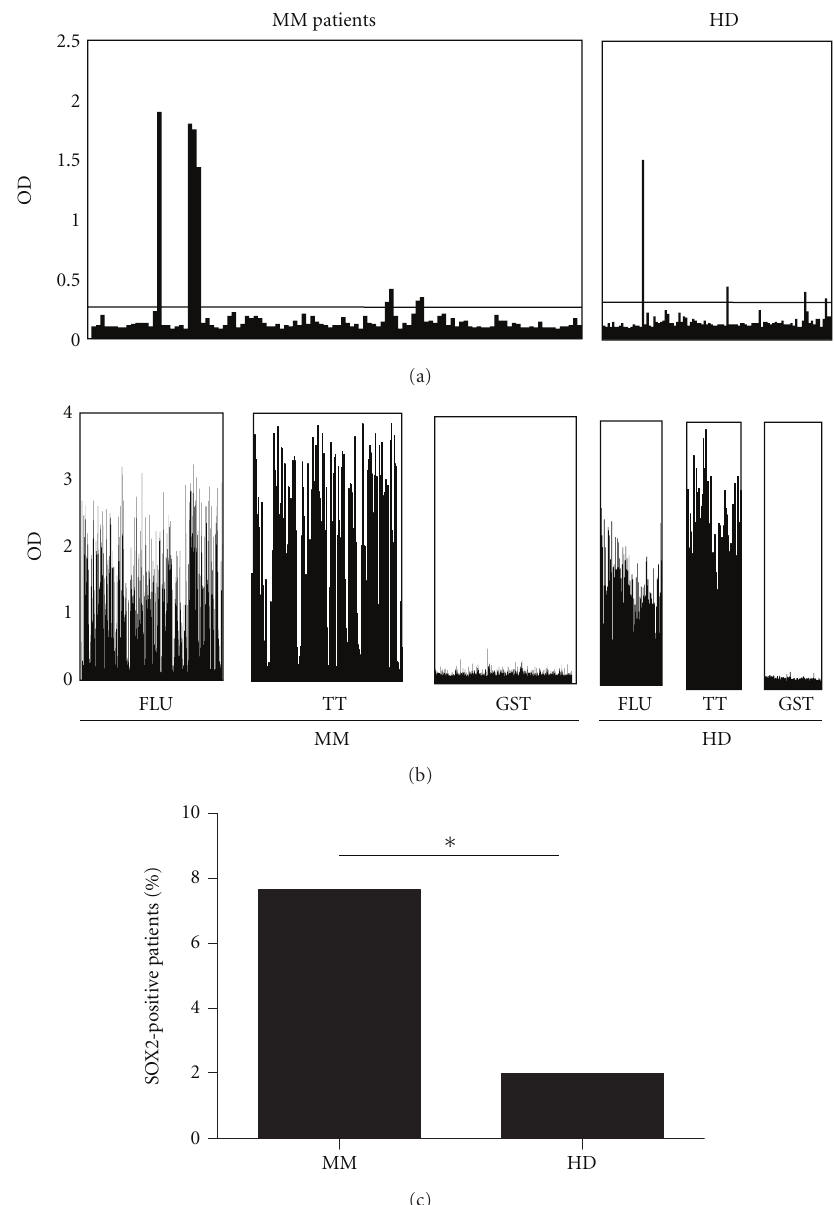
Figure 2: (a) Analysis of SOX2-specific IgG antibody responses in MM patients ( n = 1094) and in healthy donors ( n = 100). Results are shown as optical density (OD) at 405 nm. Horizontal bar represents the cut-o ff value for positivity (OD > 0.274). (b) Analysis of influenza- nucleoprotein- (FLU-), tetanus-toxoid- (TT-) and glutathione-S-transferase- (GST-) specific antibody responses in the same collective of MM patients and healthy donors. (c) Incidence of SOX2-specific antibody responses in the group of MM patients compared with the group of healthy donors (7.7% versus 2.0%). We found significantly more individuals with SOX2-specific antibody responses in the MM group than in the healthy donor group ( P < 0 .